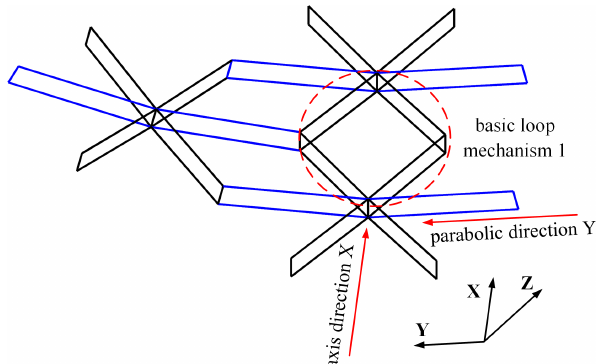
Figure 9. Basic loop mechanism 1 formed by connecting modules.